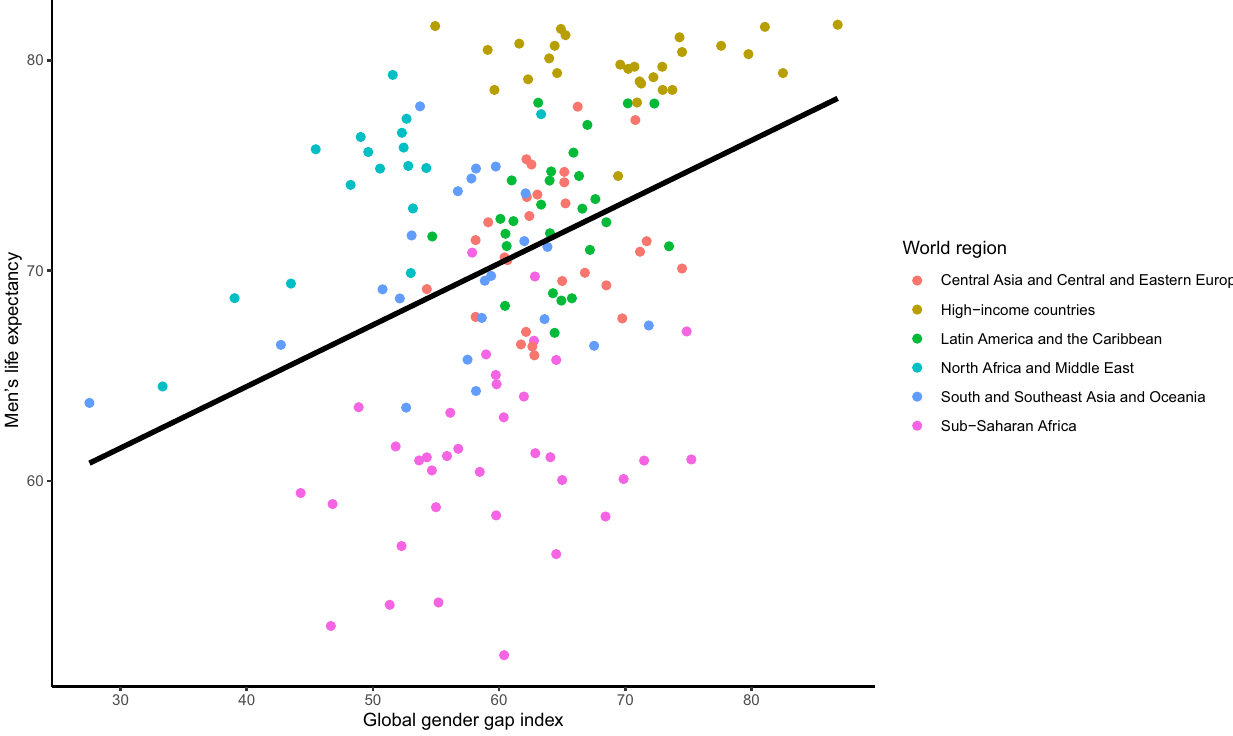
Fig 7. Cross-sectional association between the mGGGI and men’s life expectancy in 2020/1. The scatterplot displays the linear regression line for the association between the mGGGI and men’s life expectancy (2.93 [1.77 to 4.08], p-value < 0.001).